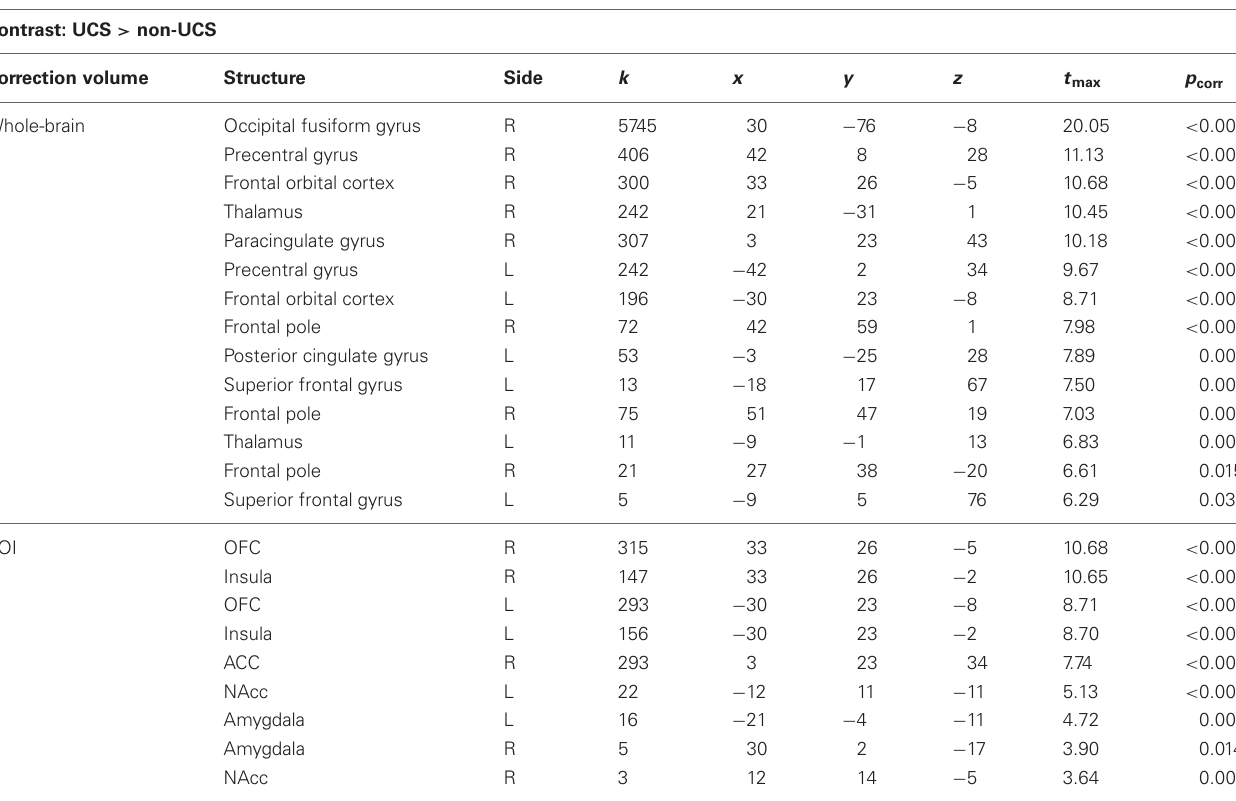
Table 1 | Correction volume, structures, cluster sizes ( k ), coordinates of peak voxels, t -values, and p corr –values (FWE correction) for the contrast UCS > non-UCS (from the conditioning